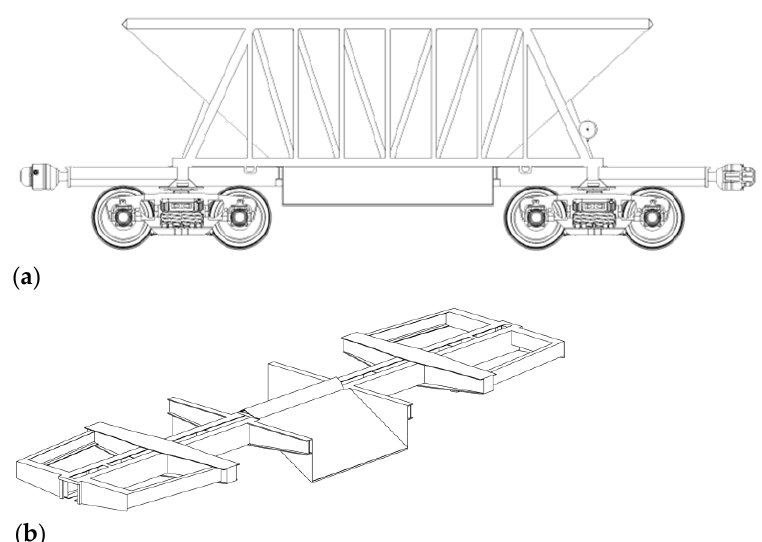
Figure 3. Hopper wagon.